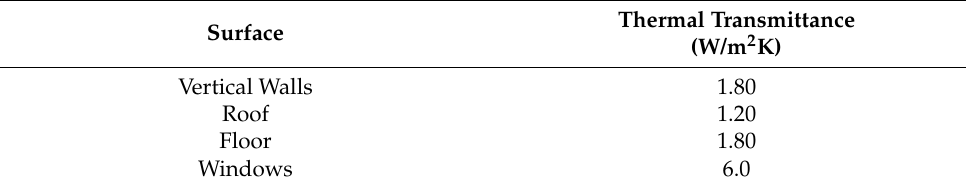
Table 2. Reference office building: U-values for the four locations [56].